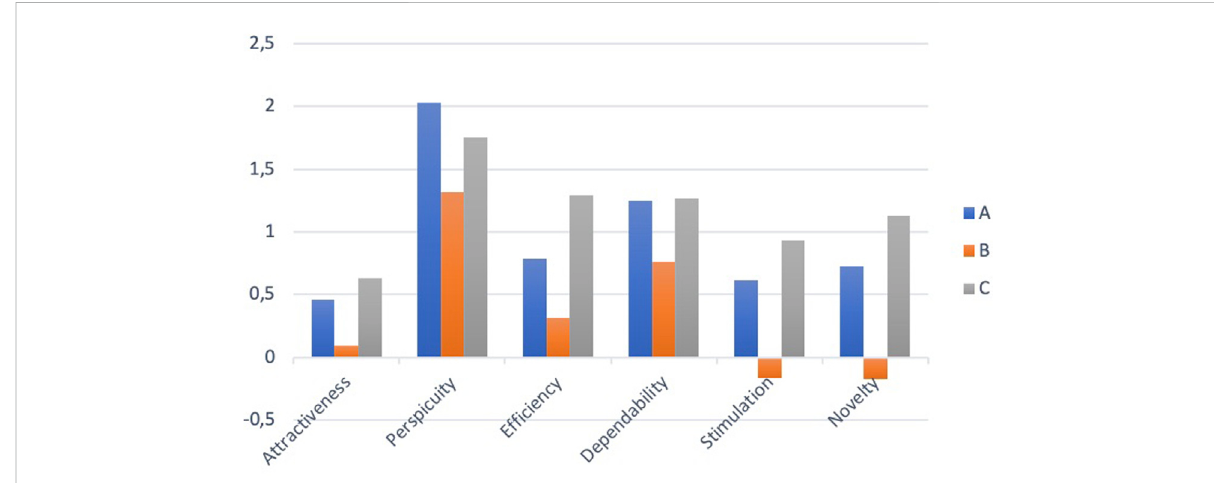
FIGURE 20 Subscale scores of the UEQ.